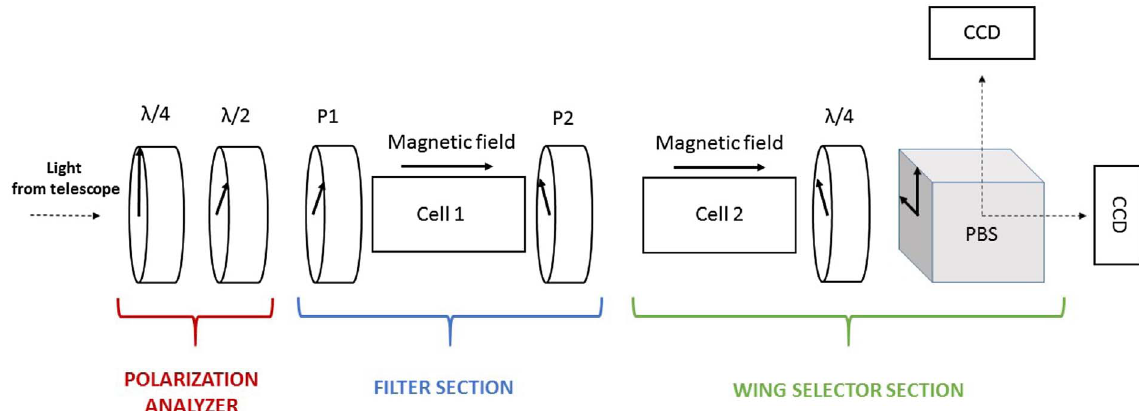
Fig. 1. MOTH simpli fi ed optical scheme of one single channel. The polarization rotator k /2 is shown at 45 (cid:3) with respect to the k /4 retarder. The hot mirror, the UV fi lter and the narrowband interference fi lter, necessary to reduce the heat load on optical systems and to select the narrow bandwidth around the MOF spectral passbands, are present in the optical path but they are not shown in the fi gure. In this scheme we show CCD cameras, however, the latest version of the MOTH is equipped with CMOS cameras as discussed in